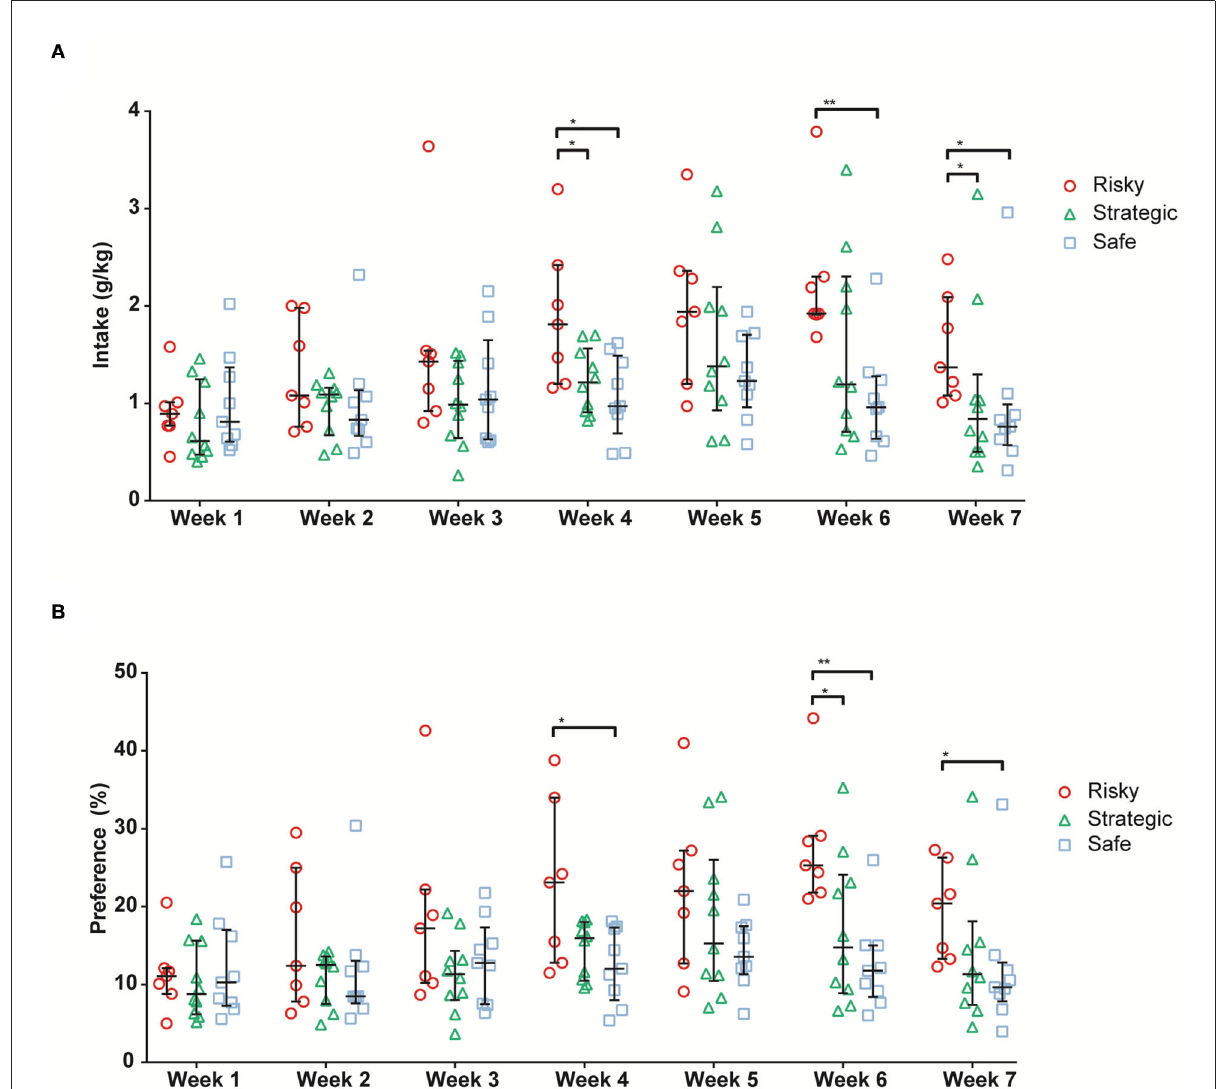
FIGURE6 Average alcohol intake [g/kg; (A) ] and alcohol preference [%; (B) ] during the 7 weeks of alcohol access in rats with risky ( n = 7), strategic ( n = 10), and safe ( n = 9) rGT strategies. Data are presented as individual rats with group median and quartile range marked. * < 0.05, ** < 0.01 ( post hoc Mann–Whitney U